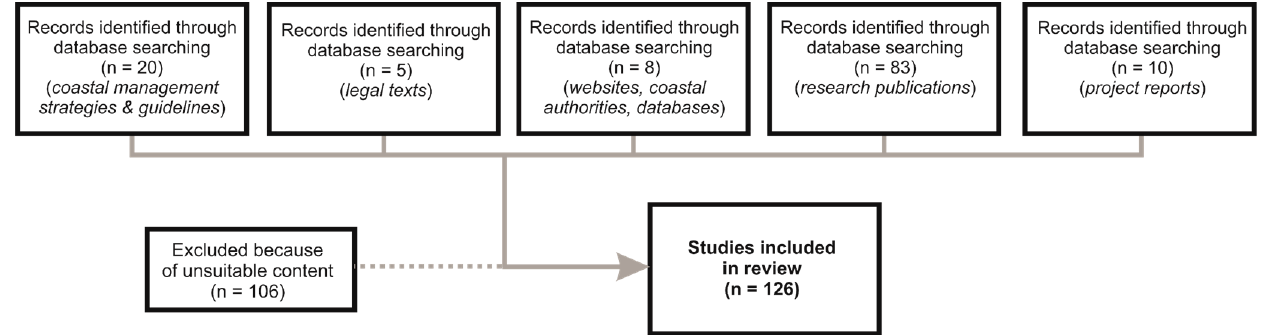
Figure 1. Flowchart for suitable studies used in this review.